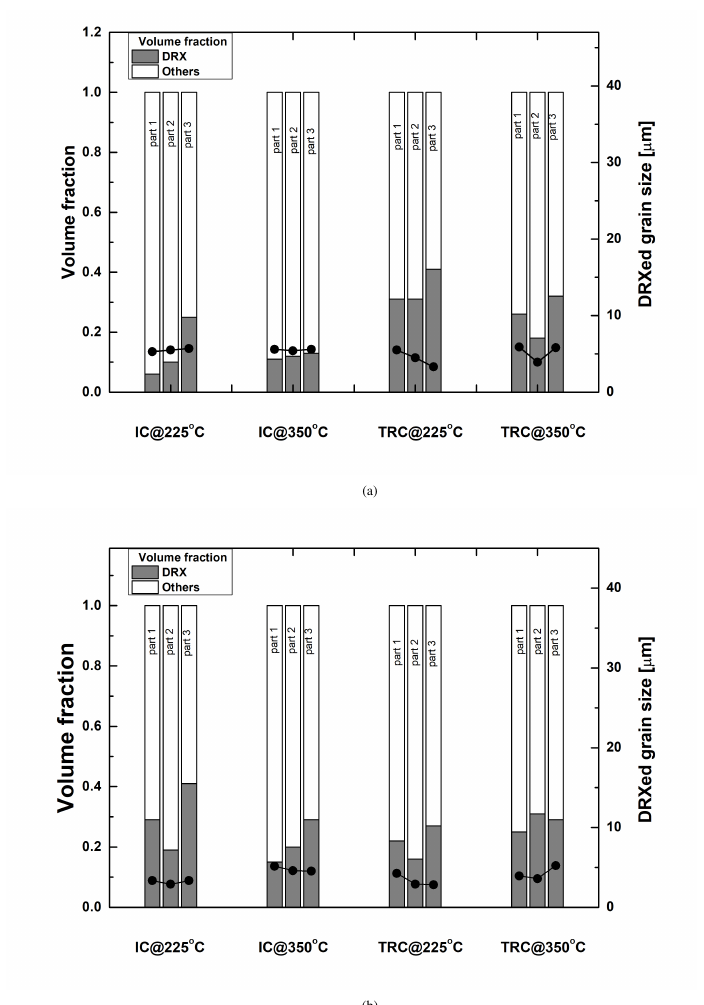
Figure 15. Volume fractions of small and large grains and their average grain size with each position of 1 drawn cups, according to the deformation rates of ( a ) 30 mm/min, and ( b ) 50 mm/min. Macroscopic microstructural evolution can be understood using misorientation